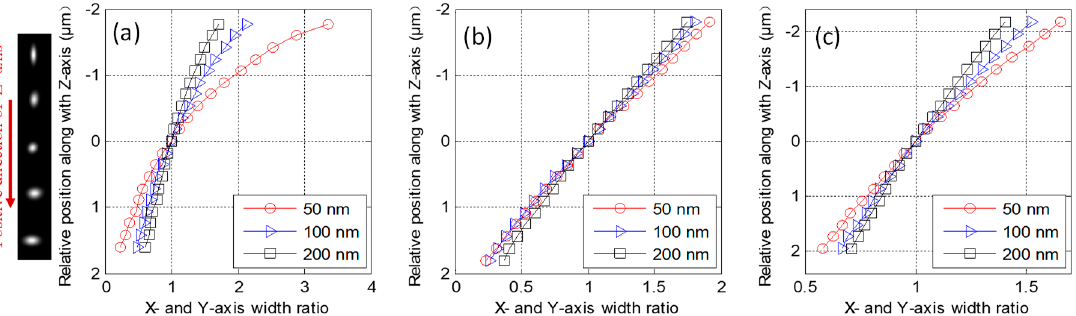
Figure 9. X- and Y-axis width ratio of three diameters of fluorescent nanoparticles versus their relative position, along with the Z-axis, at magnifications M1 ( a ), M2 ( b ), and M3 ( c ).